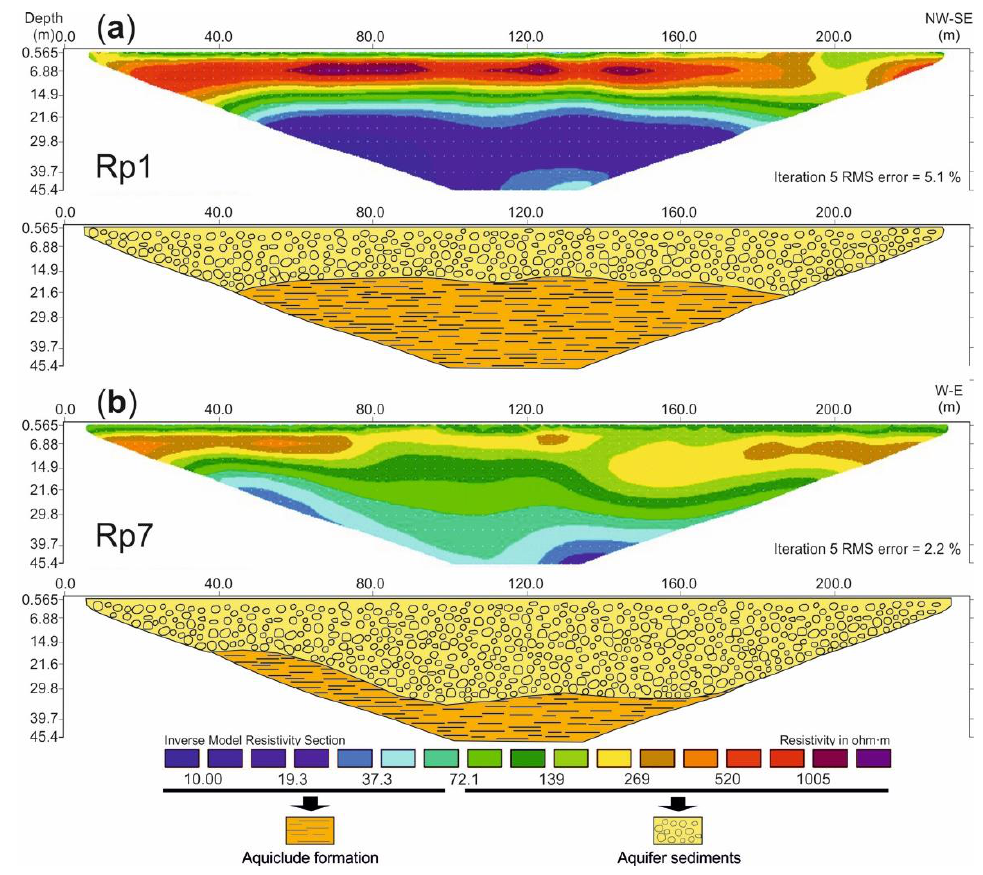
Figure 9. ( a ) ERT cross-section Rp1 and its hydrogeological interpretation, and ( b ) ERT cross-section Rp1 and its hydrogeological interpretation. Images show the variability of the upper layer and the limit between the aquifer (high ρ) and the impervious basement (low ρ).